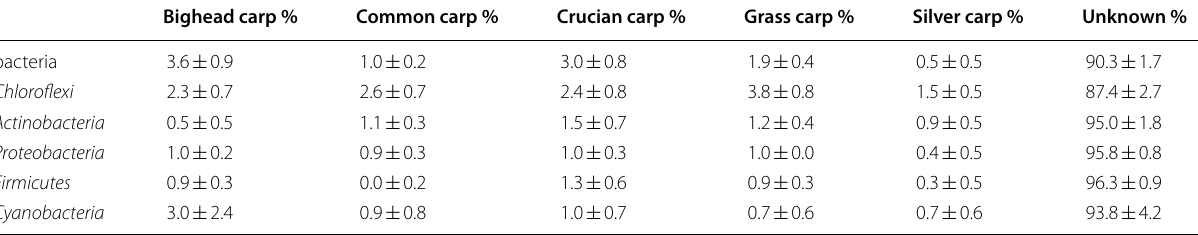
The mean values and standard deviations were obtained from 24 soil samples